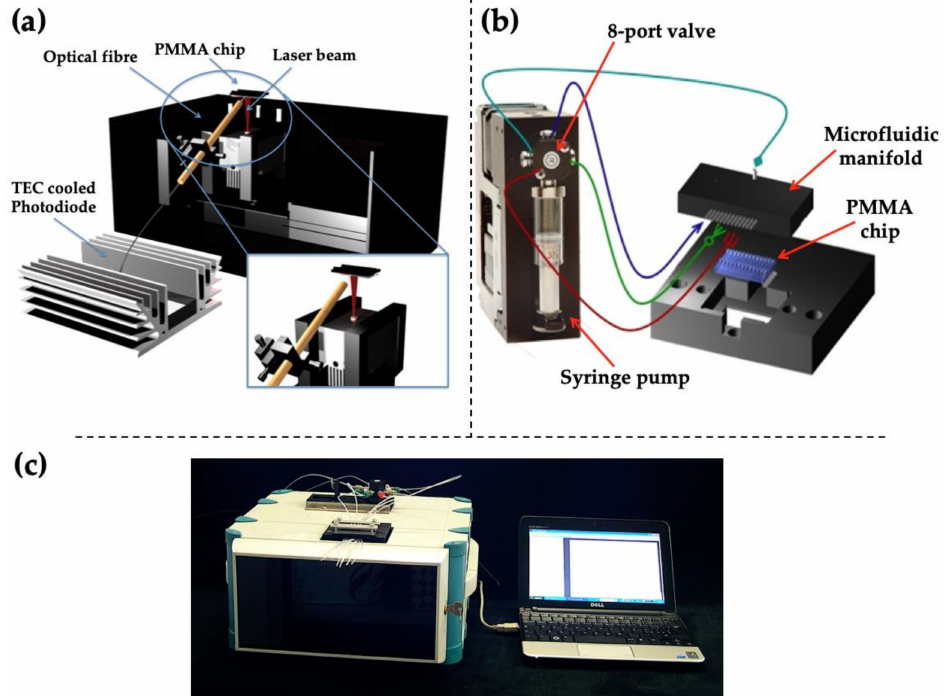
Figure 2. The POCT-prototype. ( a ) A render of the optical unit is presented, showing the laser beam as source, the flow-cell interrogated by the optical fiber, and the cooling system. ( b ) The fluidic unit is schematically represented, and it shows the fluidic connection among the PMMA-chip, the microfluidic manifold, and the 8-port valve and the syringe pump. ( c ) Picture of the integrated instrument connected to a